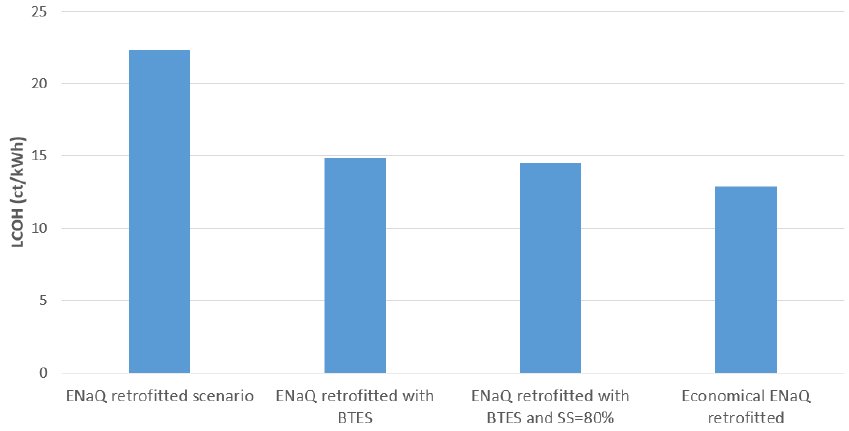
Figure 11. LCOH for ENaQ retrofitted and economical ENaQ retrofitted along with its intermediate